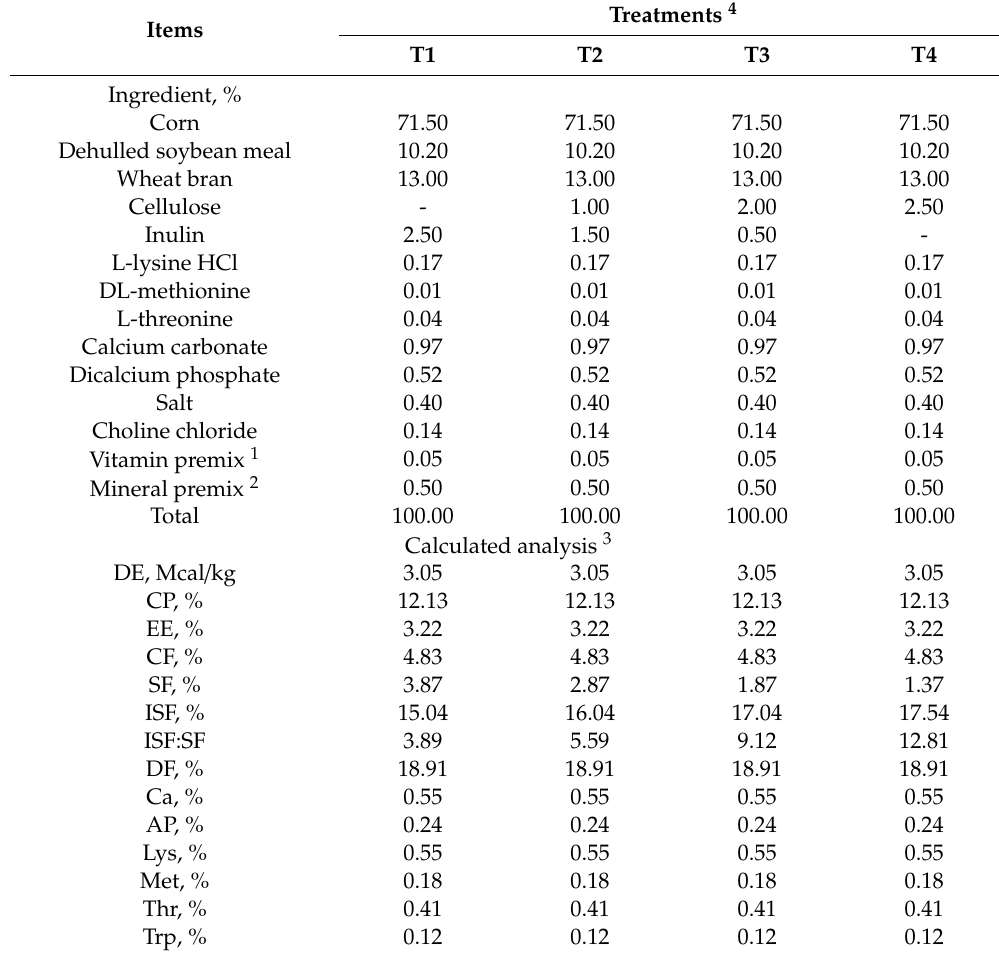
Table 1. Composition of the experimental diets during pregnancy (as-fed